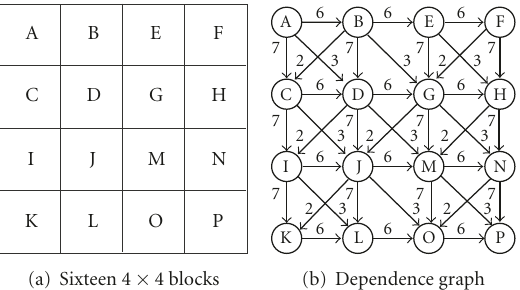
Figure 5: The dependency graph for cost